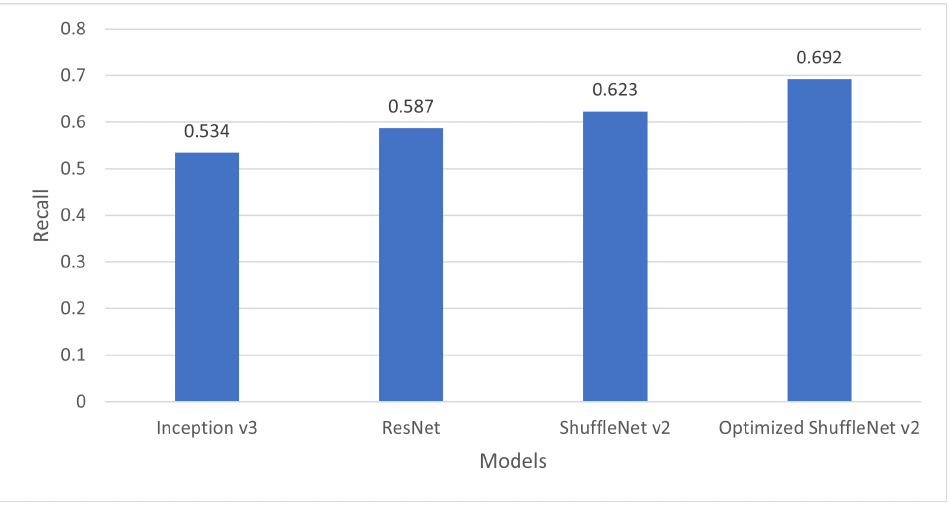
Figure 7. Classification recall of different